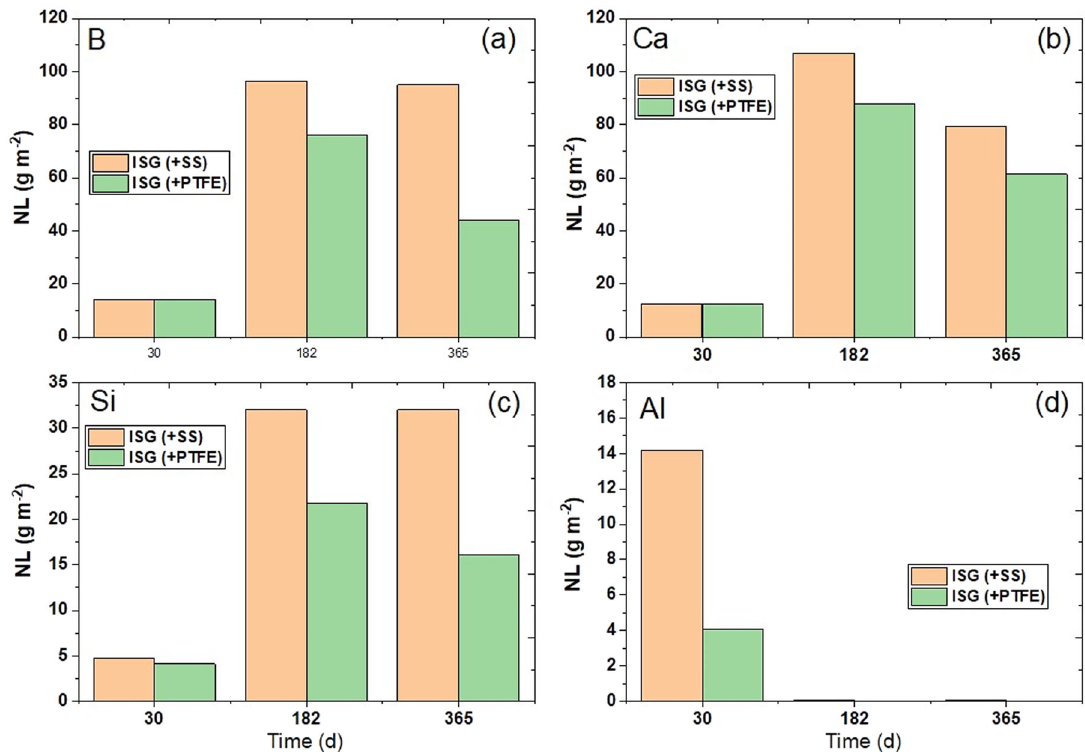
Fig. 6 Normalized loss (NL) (in g/m2) of glass constituent elements from ISG( + SS) and ISG( + PTFE) dissolution in 0.6 M NaCl. ( a ) B ( b ) Ca. ( c ) Si ( d ) Al. Zr concentration was below detection limit. For ISG( + PTFE), Al concentration was below detection limit. The data at 30 days from Guo et. al 21 . have been added for reference. Note that for Ca, the 30 day data points for ISG( + PTFE) and ISG ( + SS) are the same. The contact area between ISG and SS and ISG and PTFE has been included for these data. The concentration of Al at 182 days and 365 days for ISG( + PTFE) were below detection limit of the instrument.